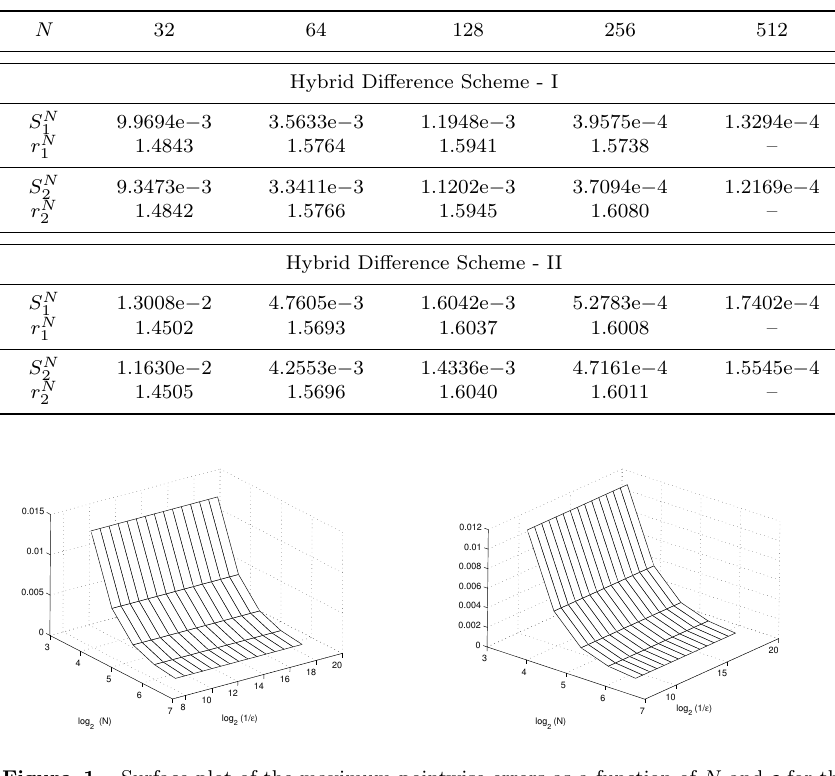
Figure 1. Surface plot of the maximum pointwise errors as a function of N and ε for the solution components Y 1 and Y 2 of the Example 1 using HDS - I.